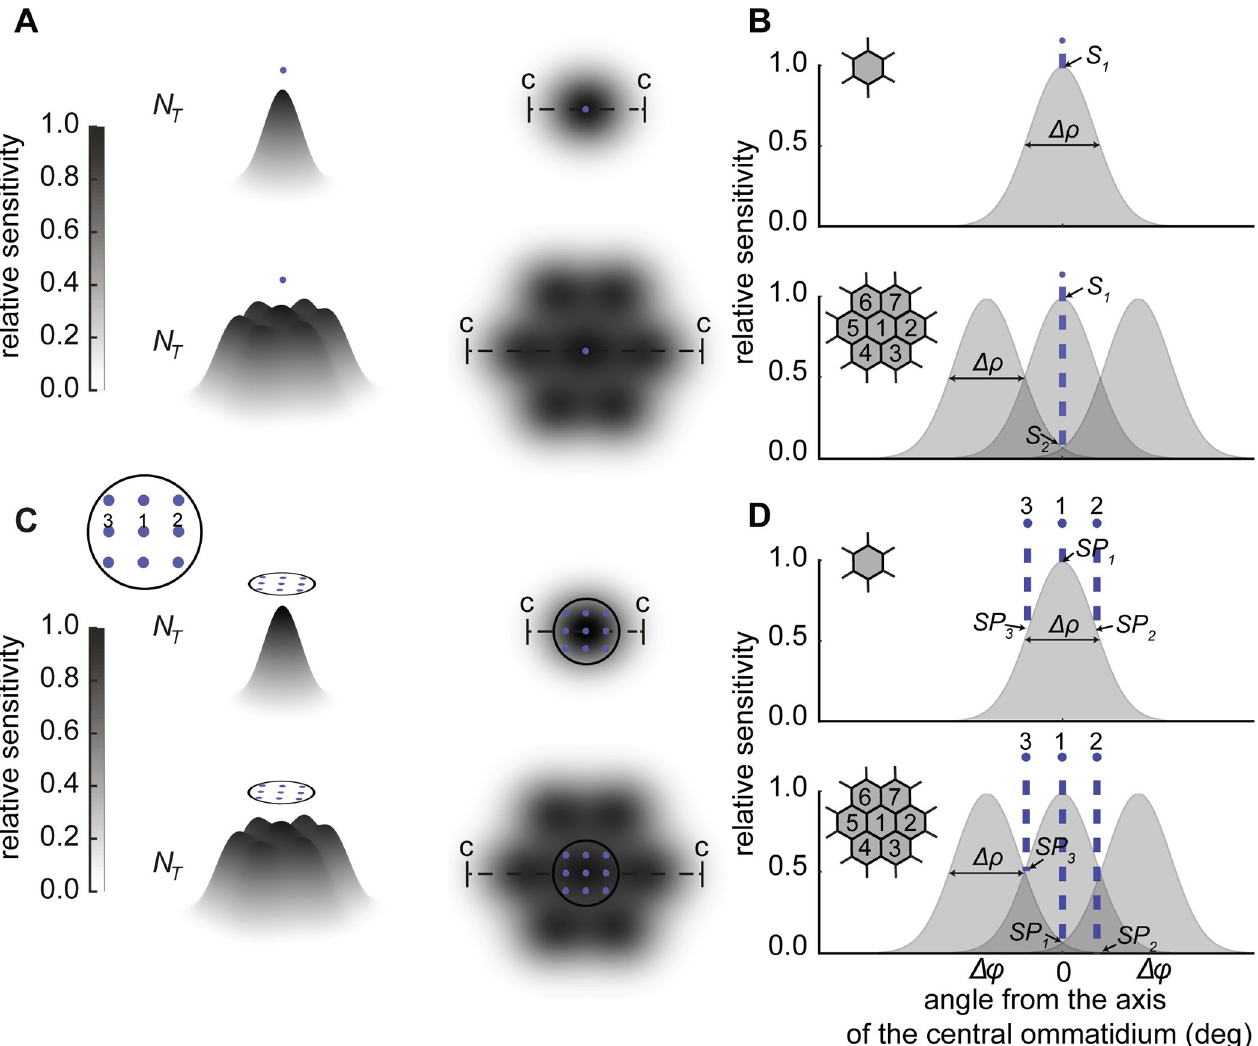
Fig 2. The sensitivity of ommatidia to point sources. (A) The receptive fields of target channels comprising either one ommatidium (upper panel) or seven ommatidia (lower panel) viewing a point source (small point depicted above receptive field). Grey levels represent the relative sensitivity of the receptive fields (darker indicating greater sensitivity) and the c-to-c dashed line represents the cross section through which the spatial sensitivity distributions shown in (B) relate. (B) Relative sensitivity of the ommatidia of target channels along the cross sections c-to-c in (A), showing the receptive fields of target channels comprising one ommatidium (upper panel) and seven ommatidia (lower panel). In the upper panel the relative sensitivity of the receptive field to the point source is denoted by S and in the lower panel the relative sensitivity of ommatidium number two to the point source (see inset in the panel) is denoted by S 1 The hexagonal array inset in both panels shows the ommatidia that are included in the target channel. (C) The receptive fields of target channels comprising either one ommatidium (upper panel) or seven ommatidia (lower panel) viewing multiple point sources across a transparent object (the extended luminous object; multiple point sources represented by small points encased in black circle above receptive fields). The inset in (C) shows the point source labels as used in (D). (D) Relative sensitivity of ommatidia in the target channels along the cross sections c-to-c in (C), showing the receptive fields of target channels comprising one ommatidium (upper panel) and seven ommatidia (lower panel). In both panels of figure (D) the relative sensitivity of the receptive field to point sources one, two and three is denoted by SP 1 , SP 2 , and SP 3 , but in the lower panel it is denoted for the receptive field of ommatidium five (see inset in the panel) only. The hexagonal array inset in both panels shows the ommatidia that are included in the target